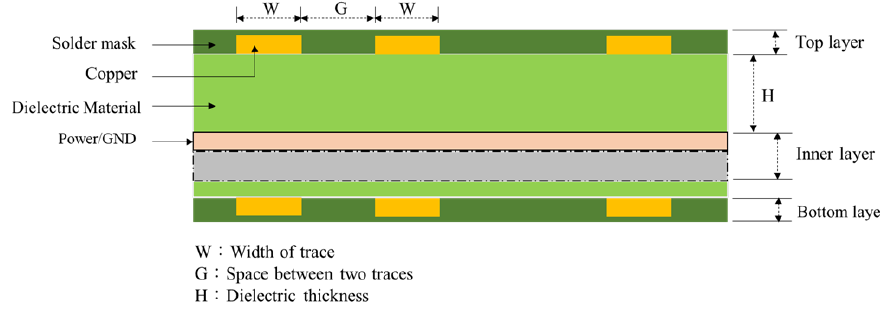
Figure 2. Multilayer PCB stack-up.